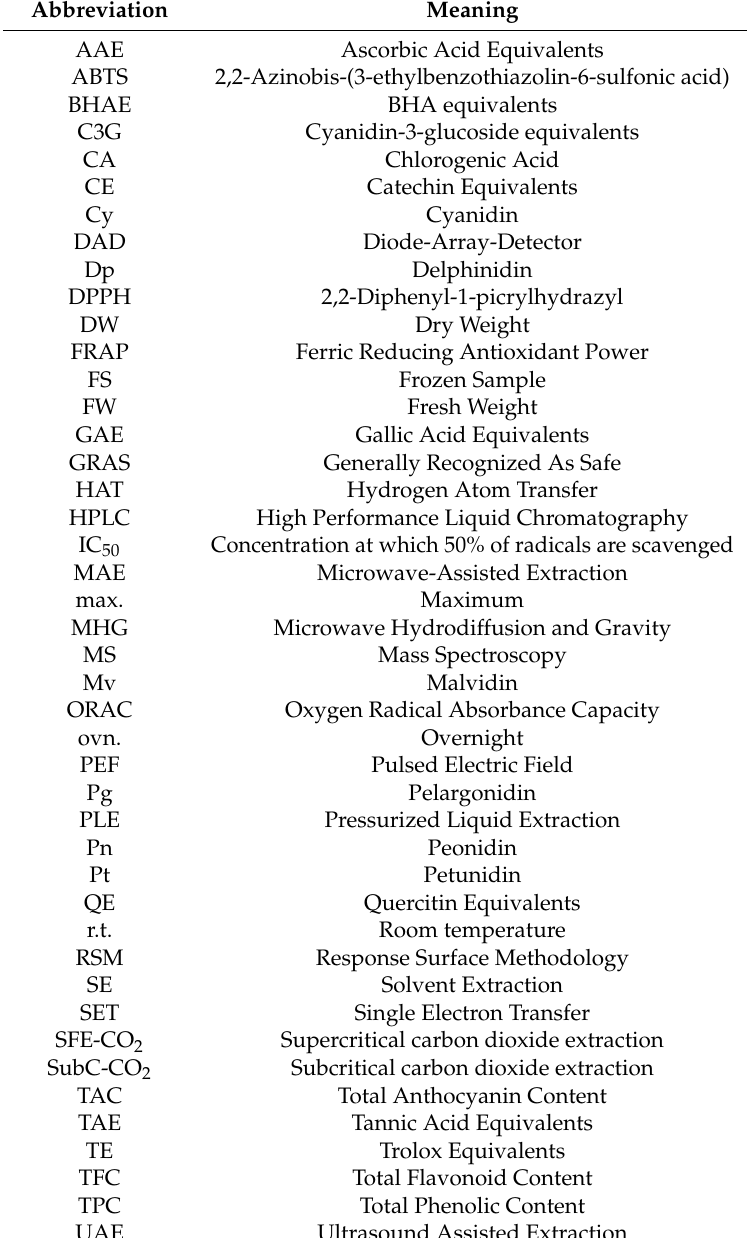
Table B1. Abbreviations